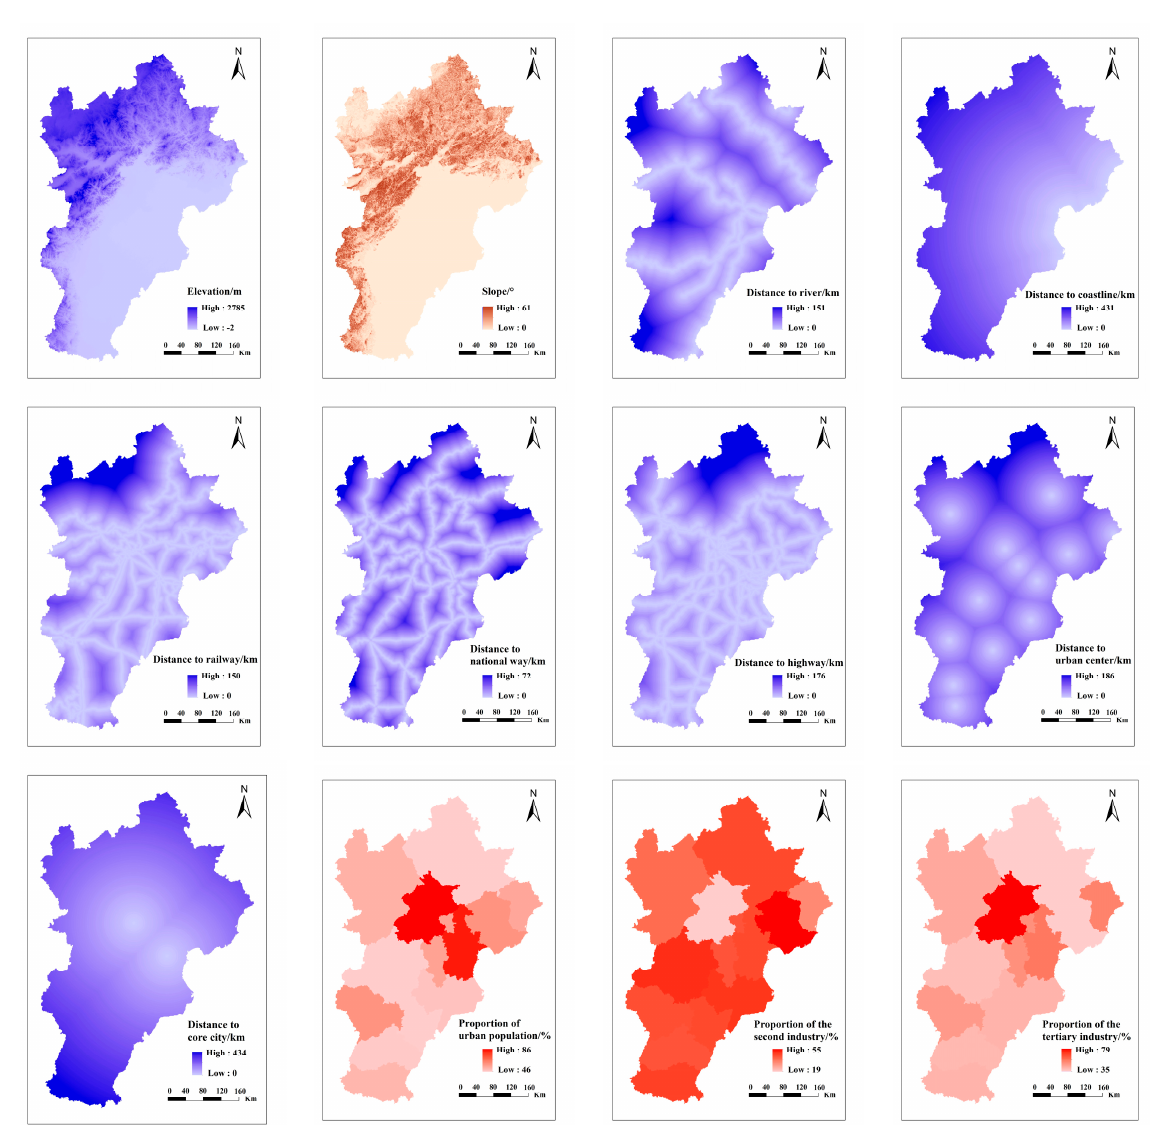
Figure 3. Spatial mapping of the drivers of construction land development in the BTH urban agglomeration